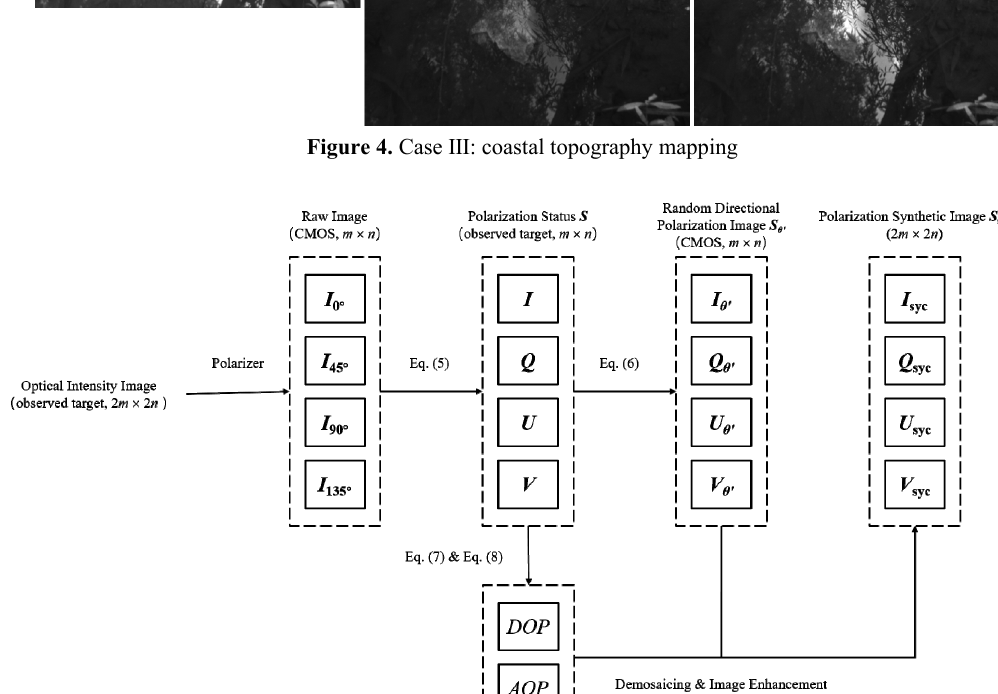
Figure 5. Flowchart of optical polarization image processing